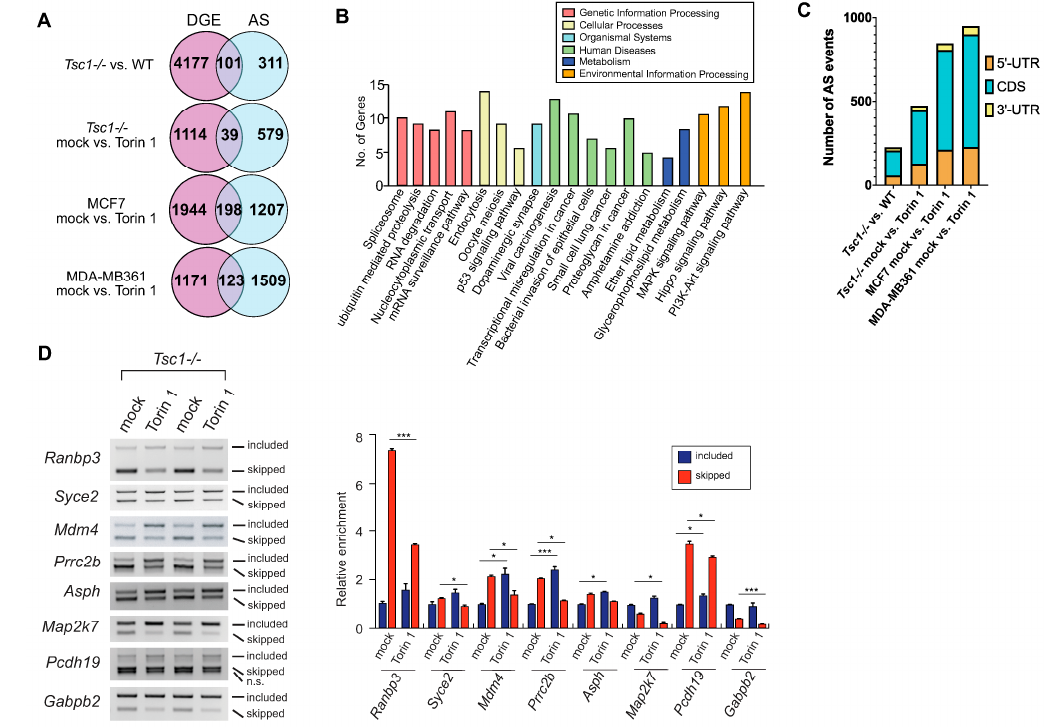
Figure 2. The mTOR-activated transcriptome features widespread exon skipping (cont’d). ( A ) Venn diagram illustrating the unique genes with differential AS and the genes overlapped with mTOR- activated differential expressed genes in the four pairs of cell lines with modulated mTOR activity. ( B ) KEGG pathway enrichment analyses performed on genes found to be differentially spliced by mTOR activation using G:profiler [38]. ( C ) Distribution of mTOR-regulated cassette exon events in different regions of the mRNA. ( D ) RT-PCR and gel electrophoresis of select genes with differential AS changes in Tsc1-/- MEFs mock vs. Torin 1 treatment. Semi-quantification of the band intensities was performed using densitometry and statistical significance between mock and treatment samples was determined by Student’s t -test. * denotes significant with p -value < 0.05; *** for p -value <